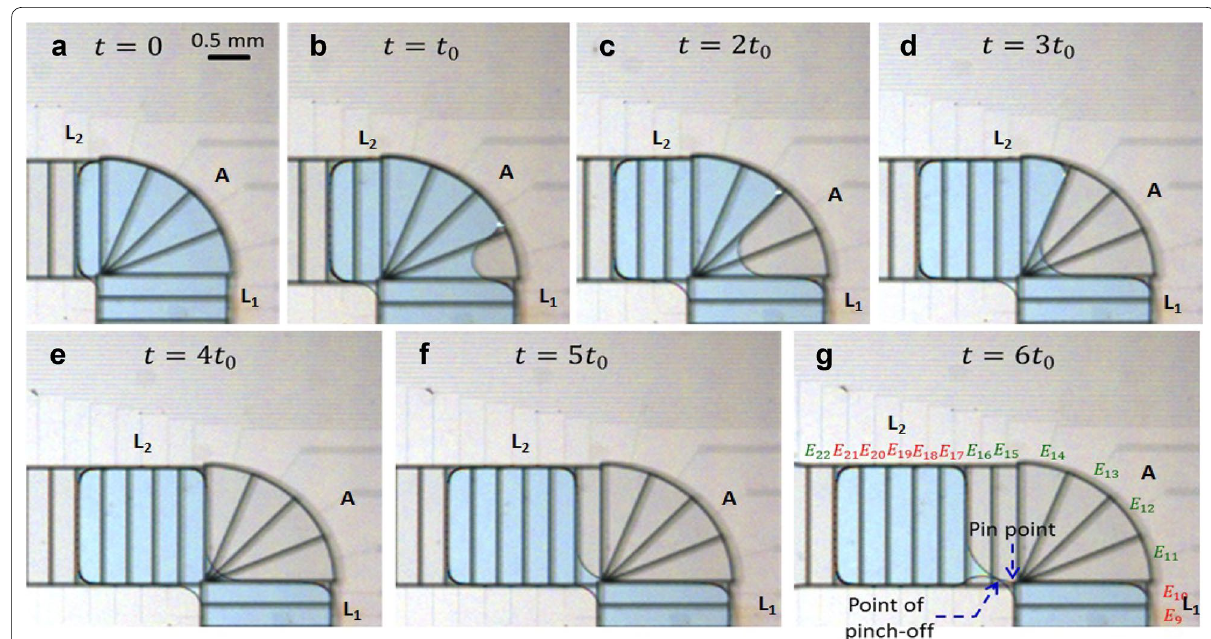
Fig. 2 Steps of droplet dispensing process in L-junction device. t 0 is the time interval between electrodes turned on and off. a Liquid meniscus entered section L2, b – e A liquid segment is being developed by sequentially turning on electrodes in section L2 while sequentially turning off electrodes in section A. f The liquid segment is shaped after all the meniscus entered to section L2. g A droplet is formed (e.g. dispensed) when the segment keeps moving in L2 so that the tail of the segment pinches